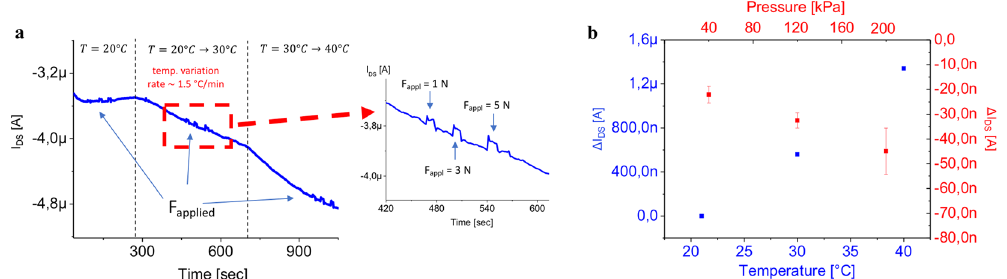
Figure 3. Simultaneous OCMFET response to force and temperature stimuli. ( a ) Dynamic response of the sensor to the simultaneous application of temperature and force stimuli to the PVDF. ( b ) Characterisation of the temperature and force